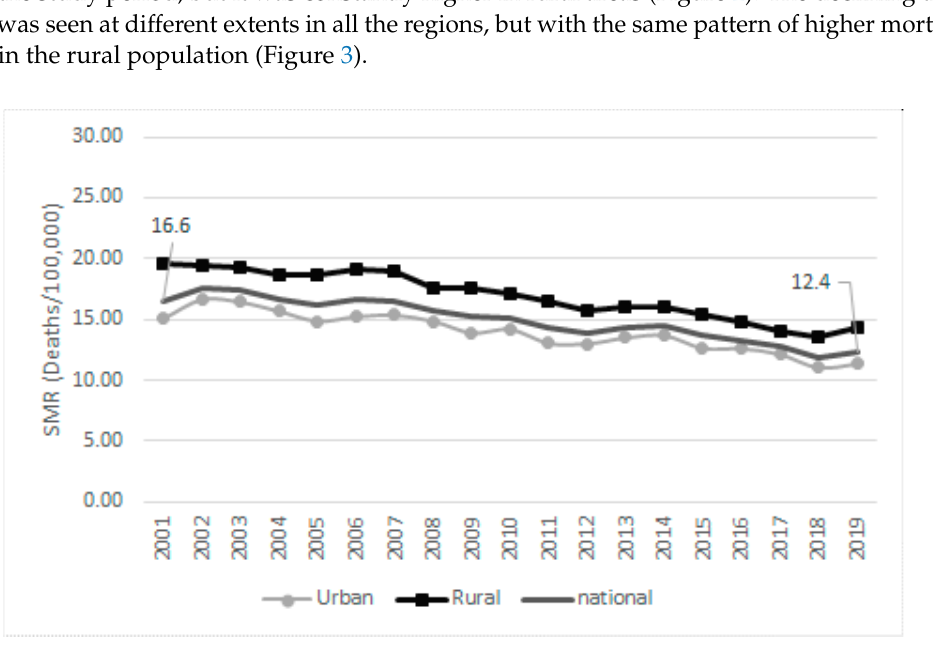
Figure 2. Trends in cervix cancer mortality, overall and by rural–urban areas, Romania, 2001–2019 (standardized mortality rates).